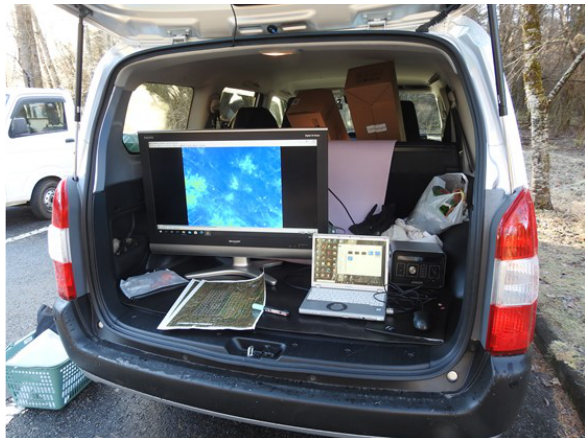
Figure 5 . A mobile identification station to identify sika deer